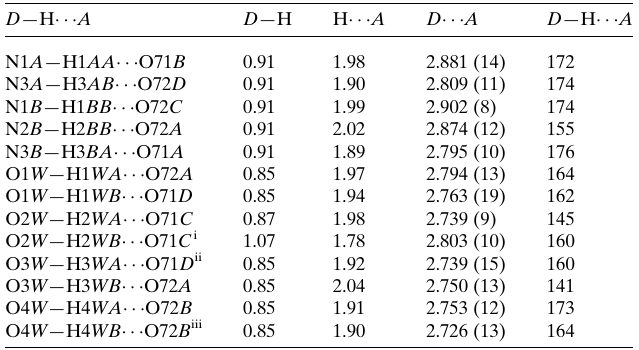
Table 2 Hydrogen-bond geometry (A˚ , (cid:4)